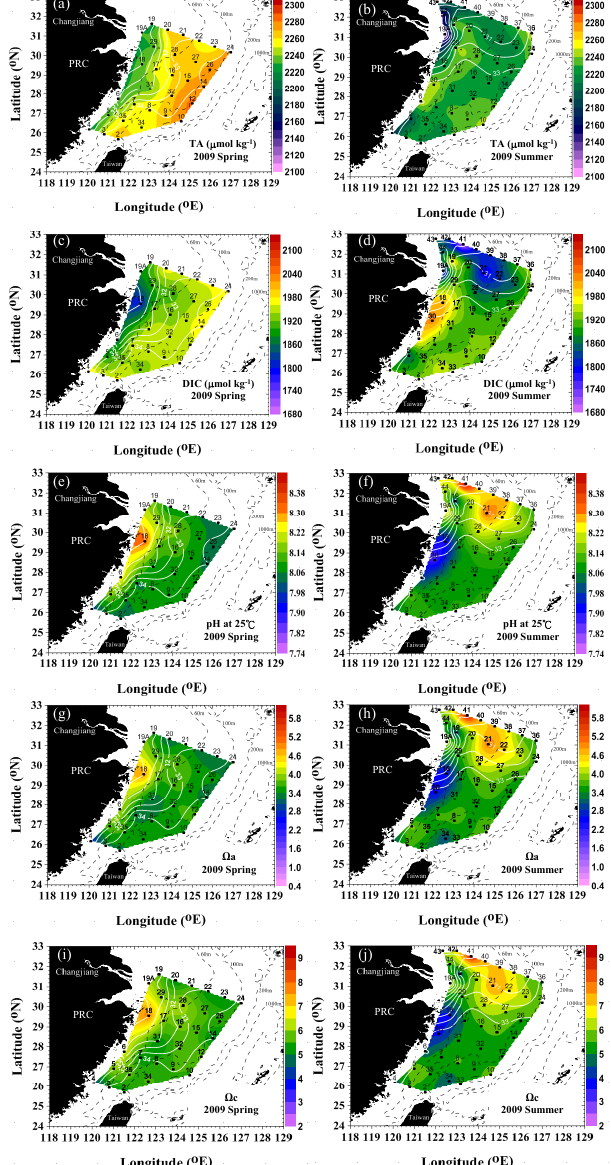
Fig. 3. Surface distributions of (a) TA in spring, (b) TA in summer, (c) DIC in spring, (d) DIC in summer, (e) p H 25 in spring, (f) pH25 in summer, (g) Wa in spring, (h) Wa in summer, (i) Wc in spring, and (j) Wc in summer 2009 in the East China Sea. Superimposed white lines are